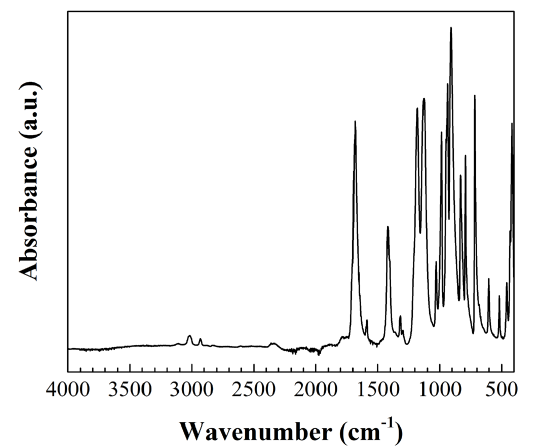
(TFA) (DMSO) ] upon excitation 2 2 3